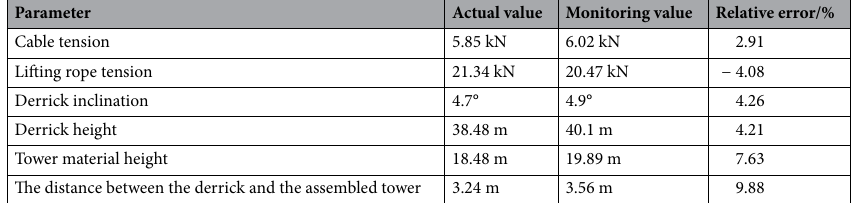
Table 2. Comparison of measured data and calculated data of the system.